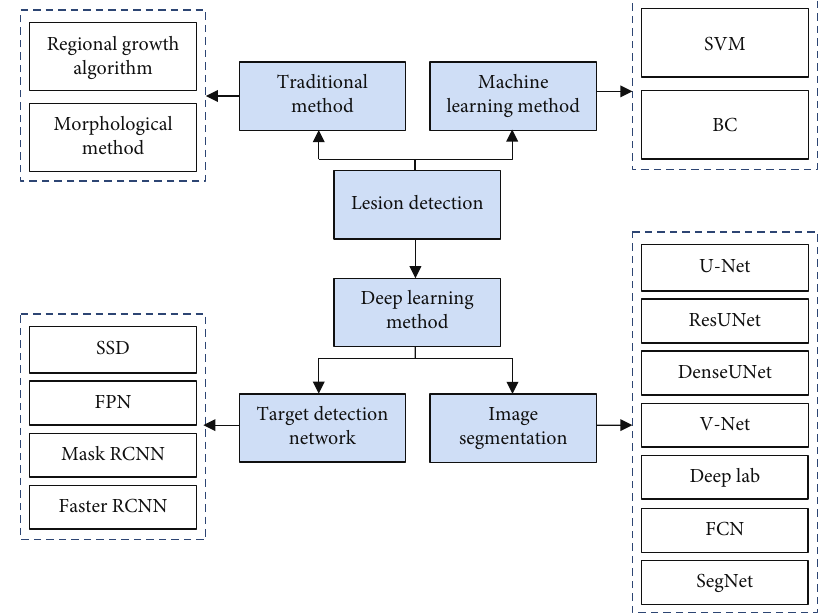
Figure 2: Lesion detection method and detection fl ow chart.